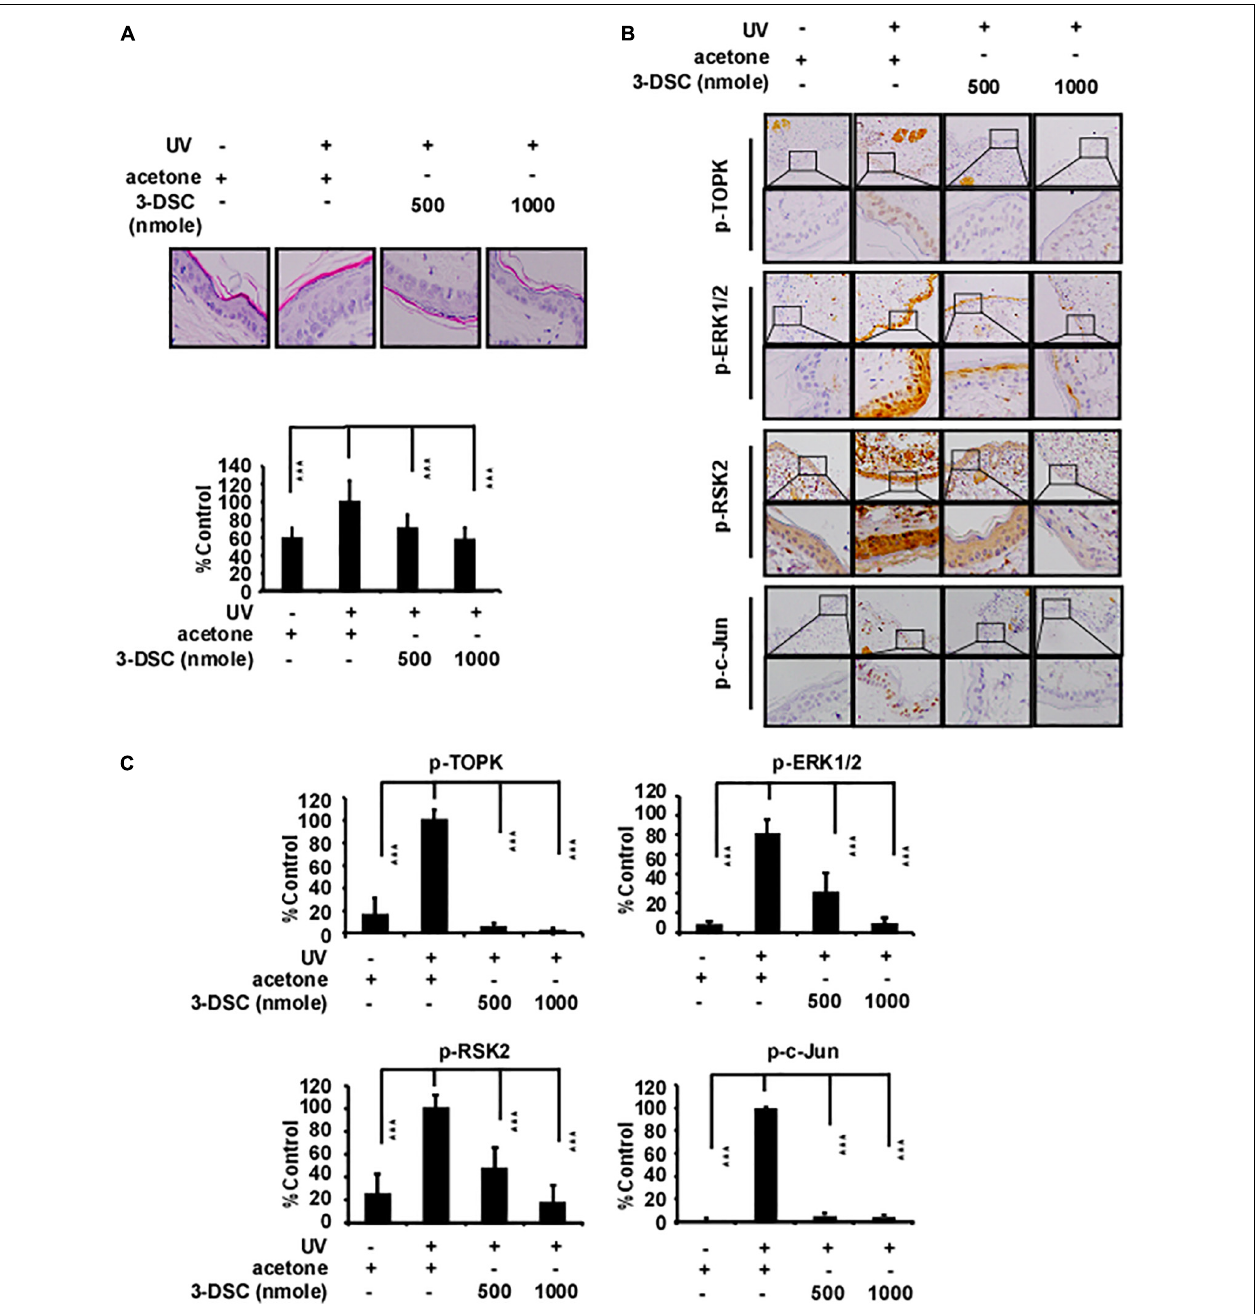
FIGURE 2 | 3-DSC decreases skin epidermal thickening caused by solar ultraviolet (SUV) exposure by targeting TOPK. (A) Representative hematoxylin and eosin (H&E) staining results of mice dorsal skin treated with or without 3-DSC prior to SUV exposure. Each group consisted of 8–10 mice. Tissue thickness was measured using a microscope ruler. Data are shown as mean ± SD values. (B) Protein expressions of p-TOPK, p-ERK, p-RSK, and p-c-Jun were detected by immunohistochemical (IHC) analysis. (C) Quantification of the IHC results in panel (B) . Data are shown as mean ± SD values. *** p <